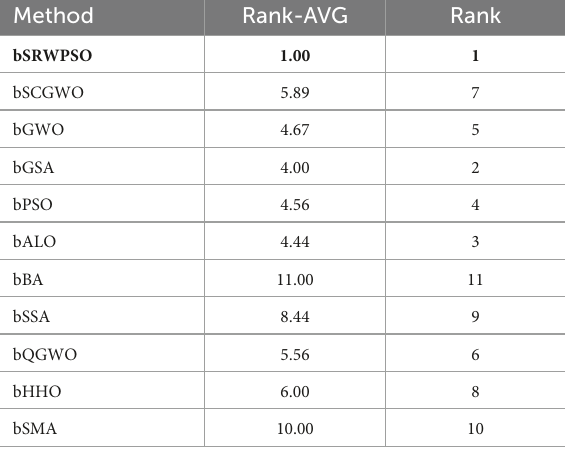
TABLE 20 The results of Friedman ranking for